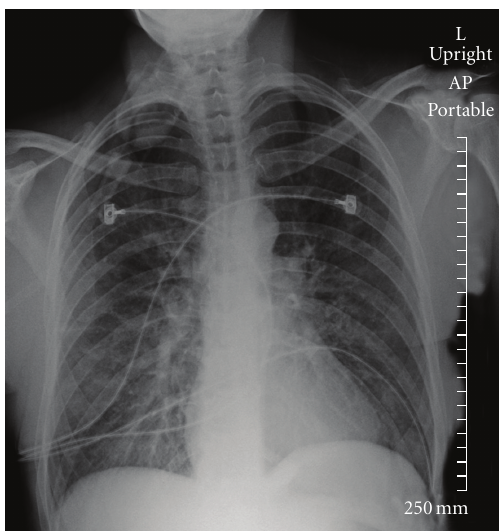
Figure 1: Case 2 chest X-ray at time 1744. Abnormal chest X- ray taken on admission to the emergency room. shows bilateral airspace with ground glass predominately on the lower right side. The image shows no Kerley B lines, vascular redistribution, or pleural e ff usions. Heart size appears